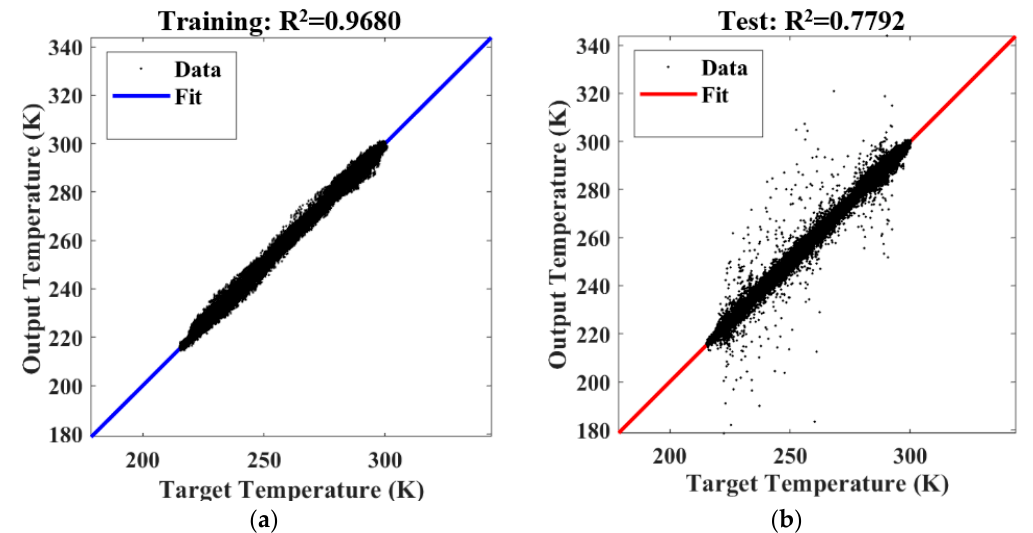
Figure 8. Result of training, Fit represents fitting results. ( a ) Correlation coefficient of the training data; ( b ) correlation coefficient of the test data .